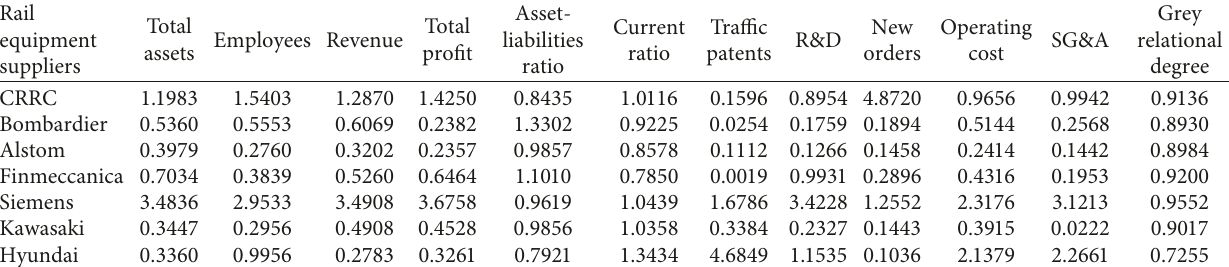
Table 7: The result of equalization and grey relational analysis.